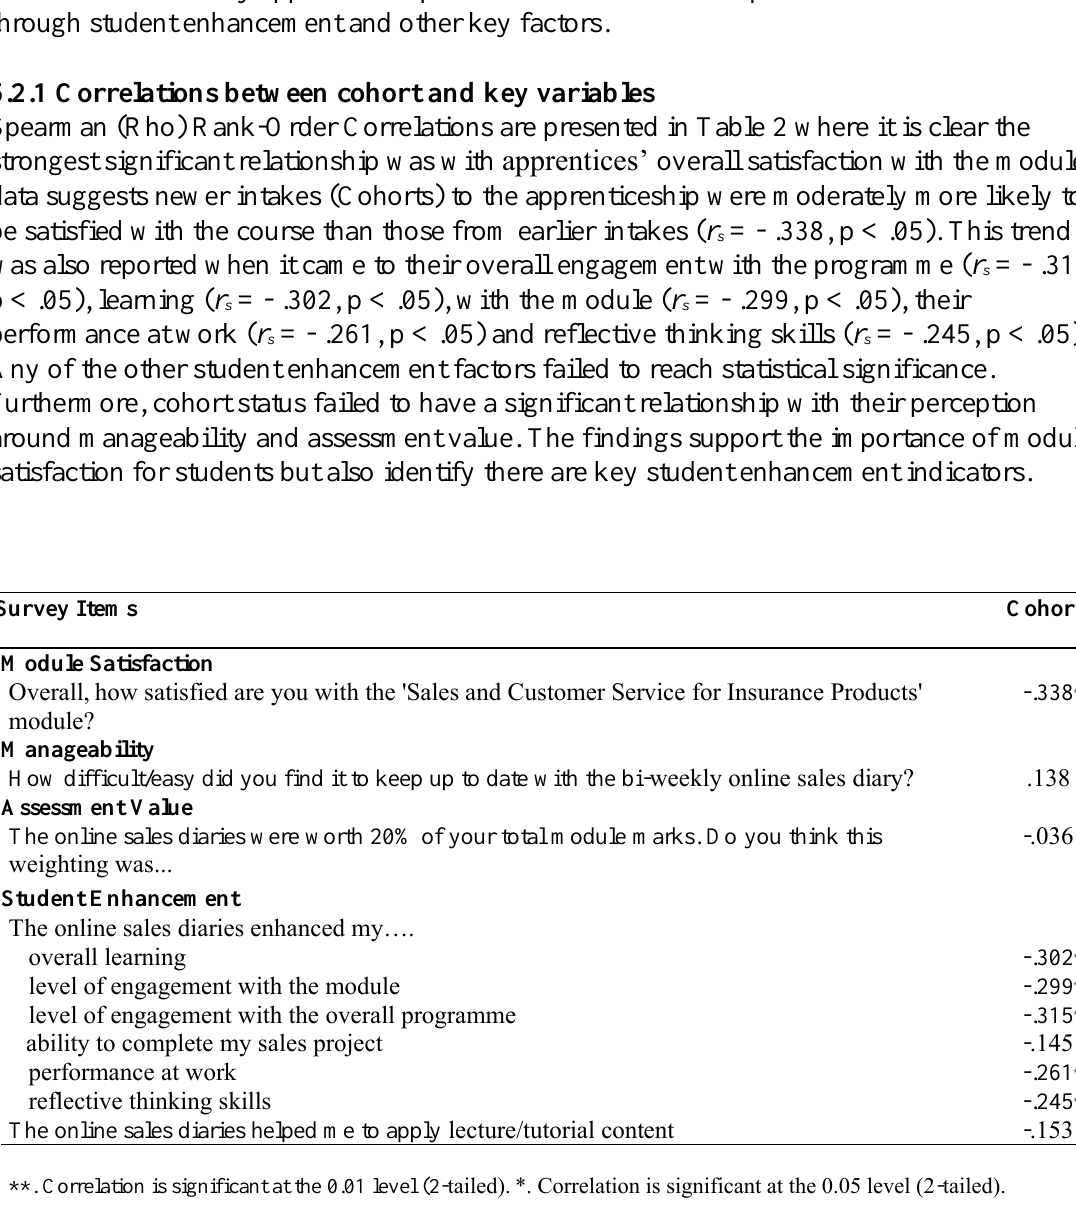
Table 2: Correlates of Academic